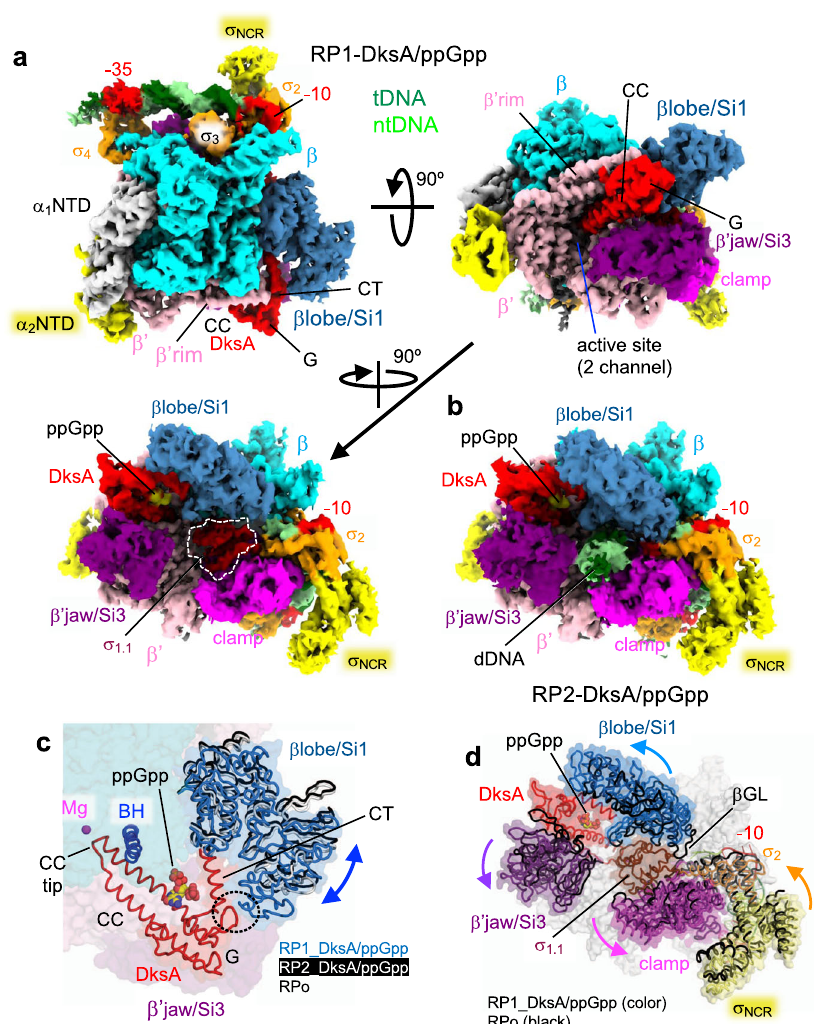
Fig. 4 Cryo-EM structures of the RNAP- rrnB P1 complex with DksA/ppGpp (RP-DksA/ppGpp). a Orthogonal views of the RP1-DksA/ppGpp cryo-EM density map. DNA, RNAP and DksA (G, G domain; CC, CC domain; CT, CT-helix) are indicated and colored. σ 1.1 is highlighted by a white dash. b The RP2- DksA/ppGpp cryo-EM density map. The downstream DNA is accommodated in the RNAP cleft. c Close-up view of the β lobe/Si1 conformational changes upon DksA binding, σ 1.1 ejection and downstream DNA binding. The structures of the β lobe/Si1 in RP1-DksA/ppGpp (light blue), RP2-DksA/ppGpp (white), and RPo (black) are depicted as ribbon models with transparent surfaces and ribbon models (DksA, BH: bridge helix) of RP1-DksA/ppGpp. The interaction between β lobe/Si1 and DksA in RP1-DksA/ppGpp is highlighted by a black dashed oval. d Conformational changes in the RNAP mobile domains upon binding of DksA/ppGpp. The structures of the RNAP mobile domains in RP1-DksA/ppGpp (colored) and RPo (black) are depicted as ribbon models with transparent surfaces of